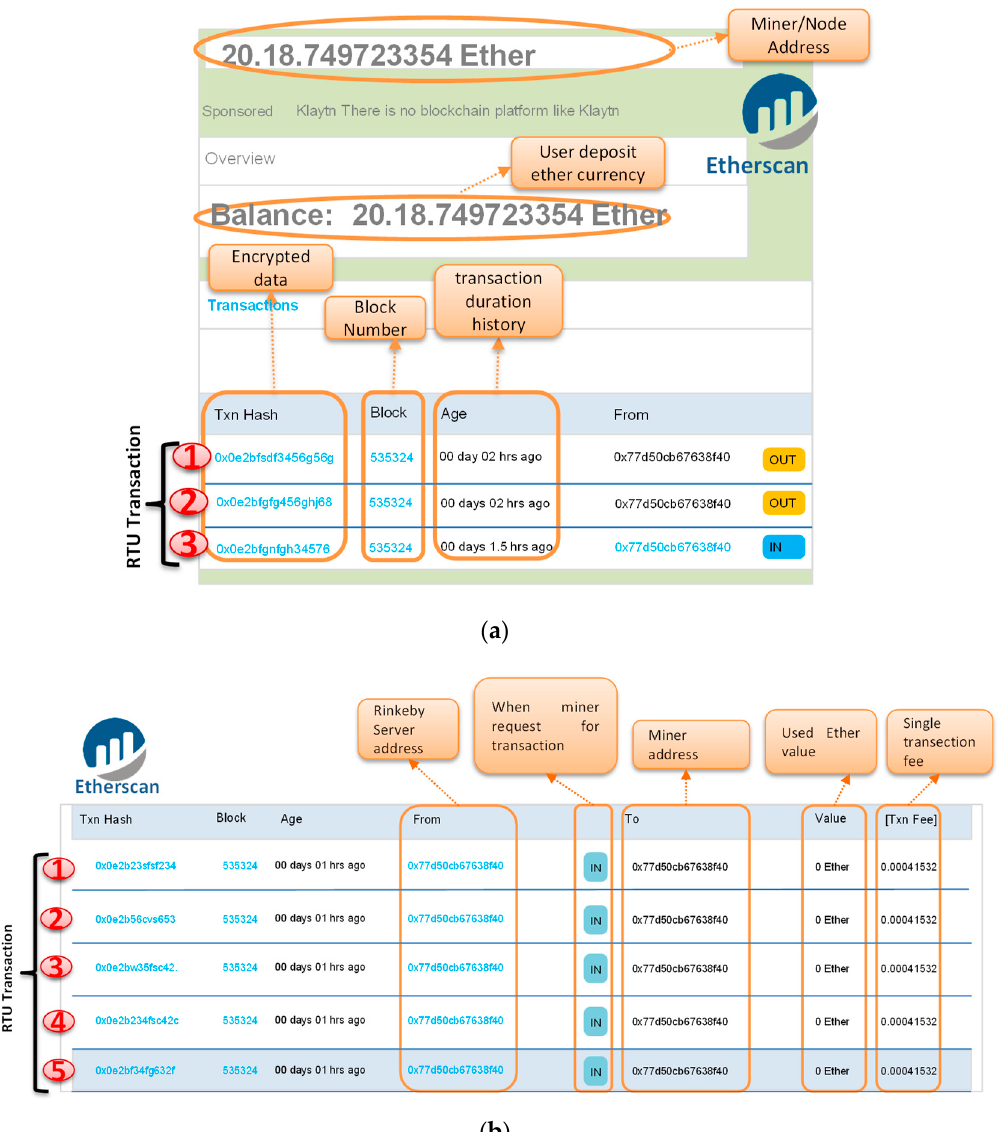
Figure 9. ( a ) Transaction added in the Rinkeby server. ( b ) Inspecting the smart-contract balance on Etherscan.